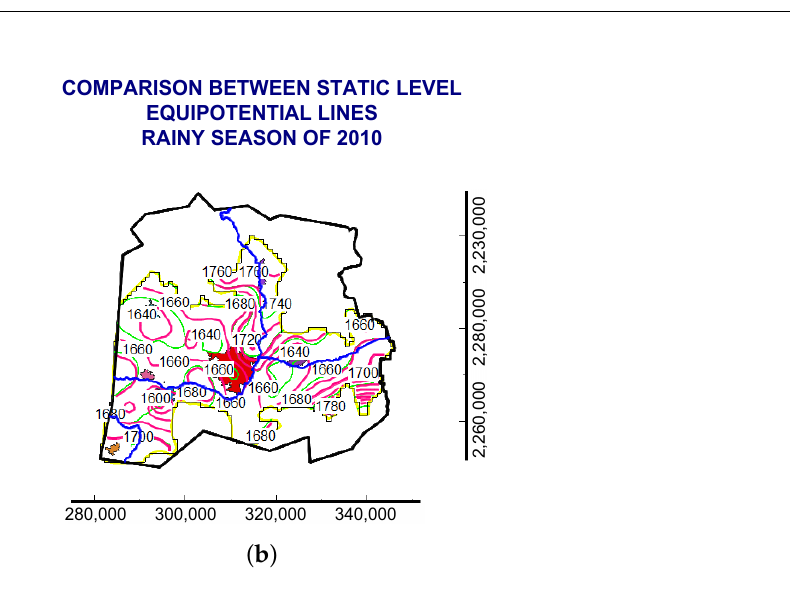
Figura 2.9: Cargas hidr´aulicas en Estado Estacionario de la temporada de Lluvias, donde la mayor